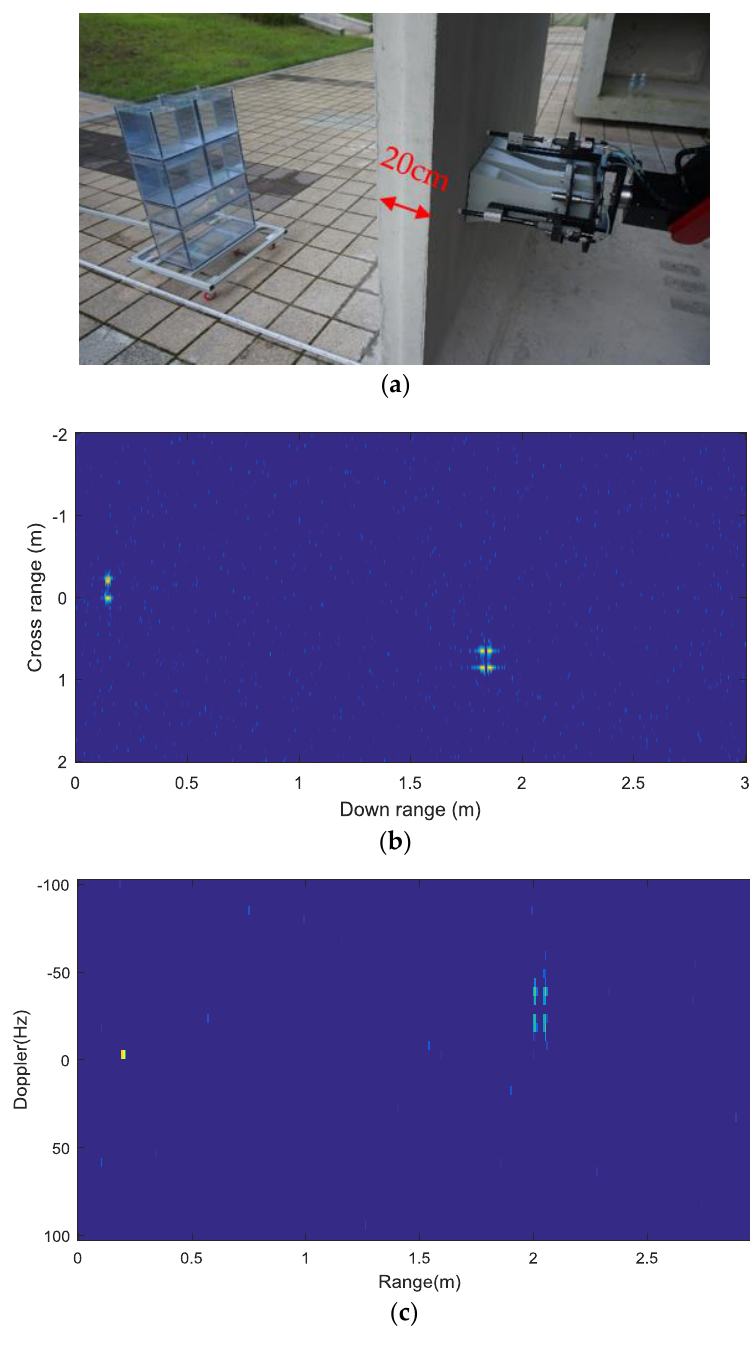
Figure 12. ( a ) Imaged outdoor scene; water target and TWRI system. ( b ) One frame of detection results of multi targets (water blocks) behind the wall when 𝑀̂ = 5. ( c ) One frame of Range-Doppler maps, showing the Doppler frequency.